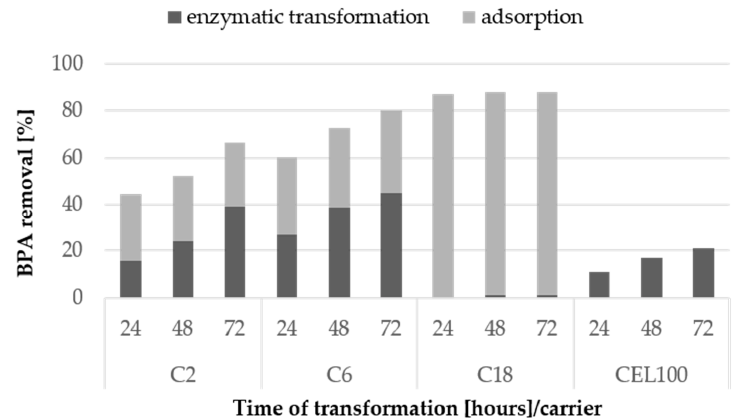
Figure 9. Enzymatic transformation and adsorption of BPA at the concentration of 10 mg / L using laccase immobilised covalently and via adsorption on selected carriers after 24, 48 and 72 h. The standard error of the results did not exceed 5%.